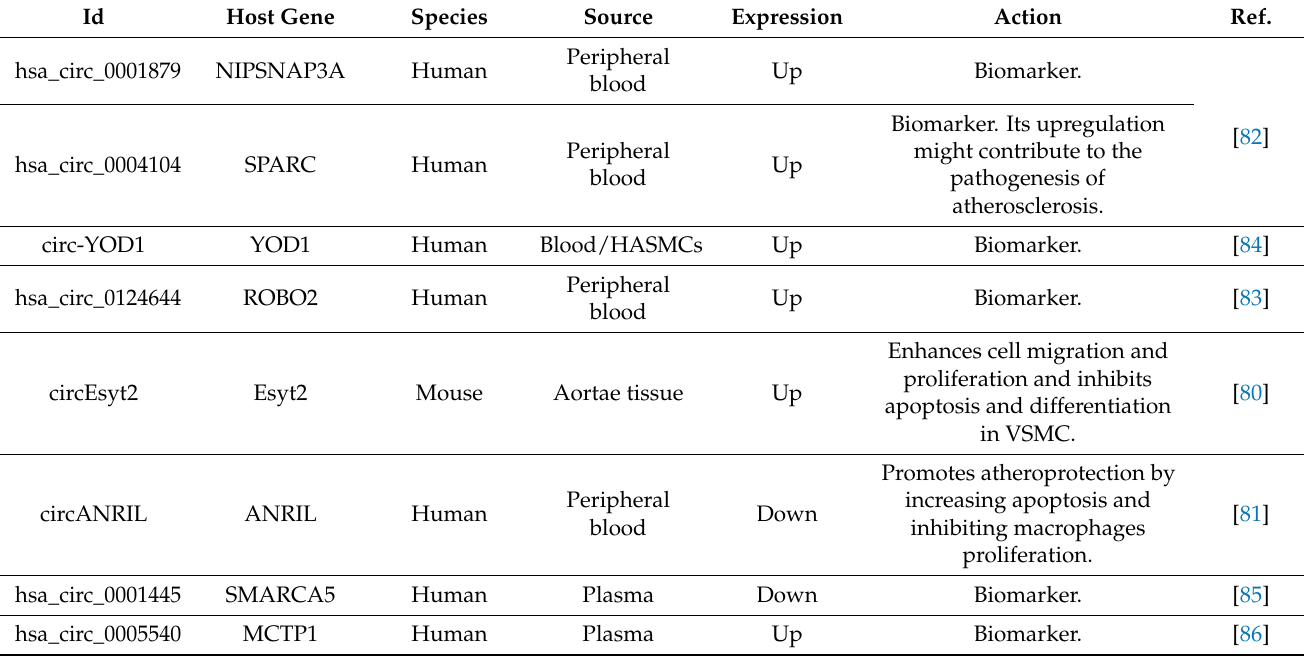
Table 3. List of circRNAs associated with